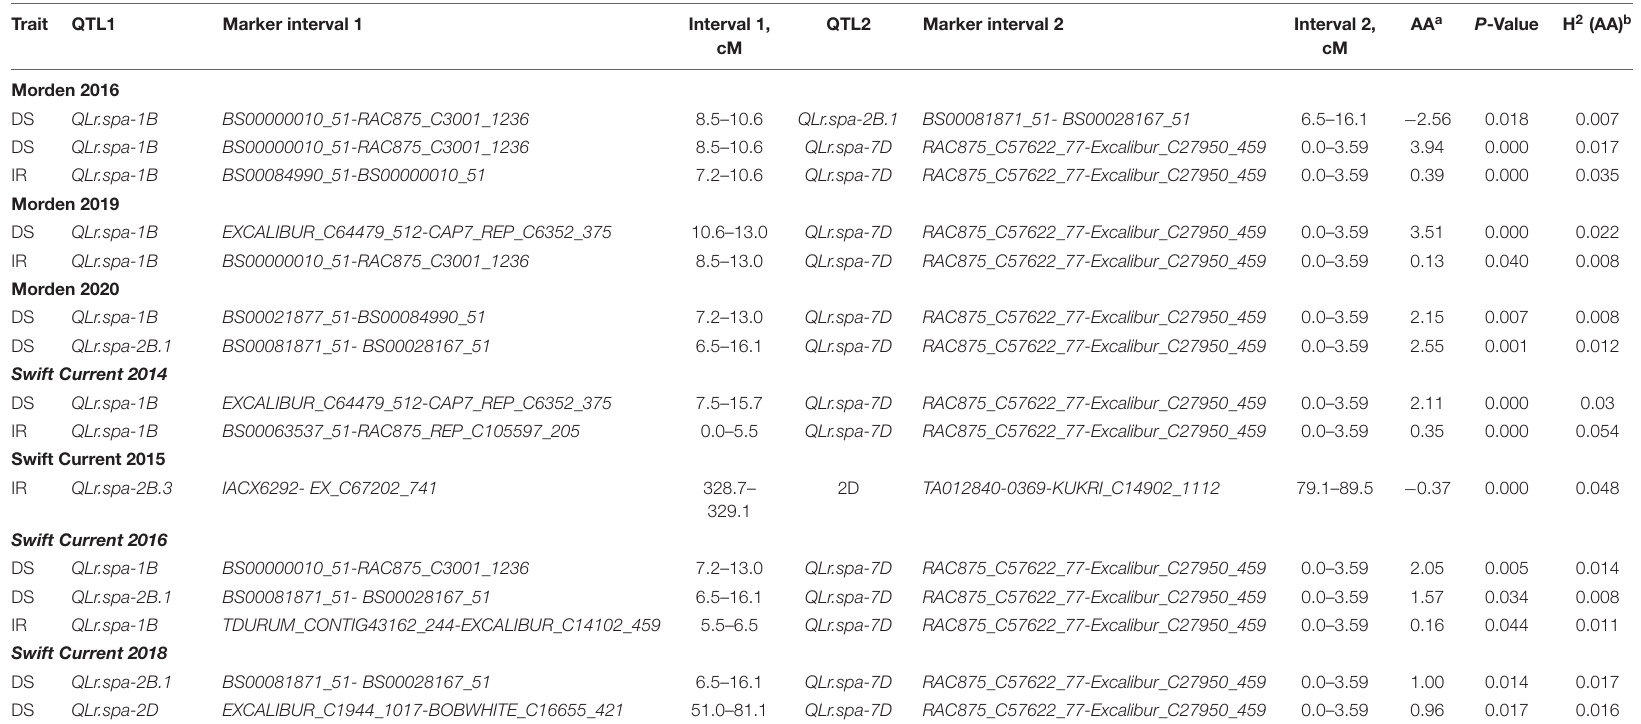
TABLE 6 | Epistatic interactions between Carberry leaf rust resistance genes detected by QTLNetwork in the Carberry/Thatcher population evaluated at Morden, MB for 3 years and Swift Current, SK for 4 years. Trait